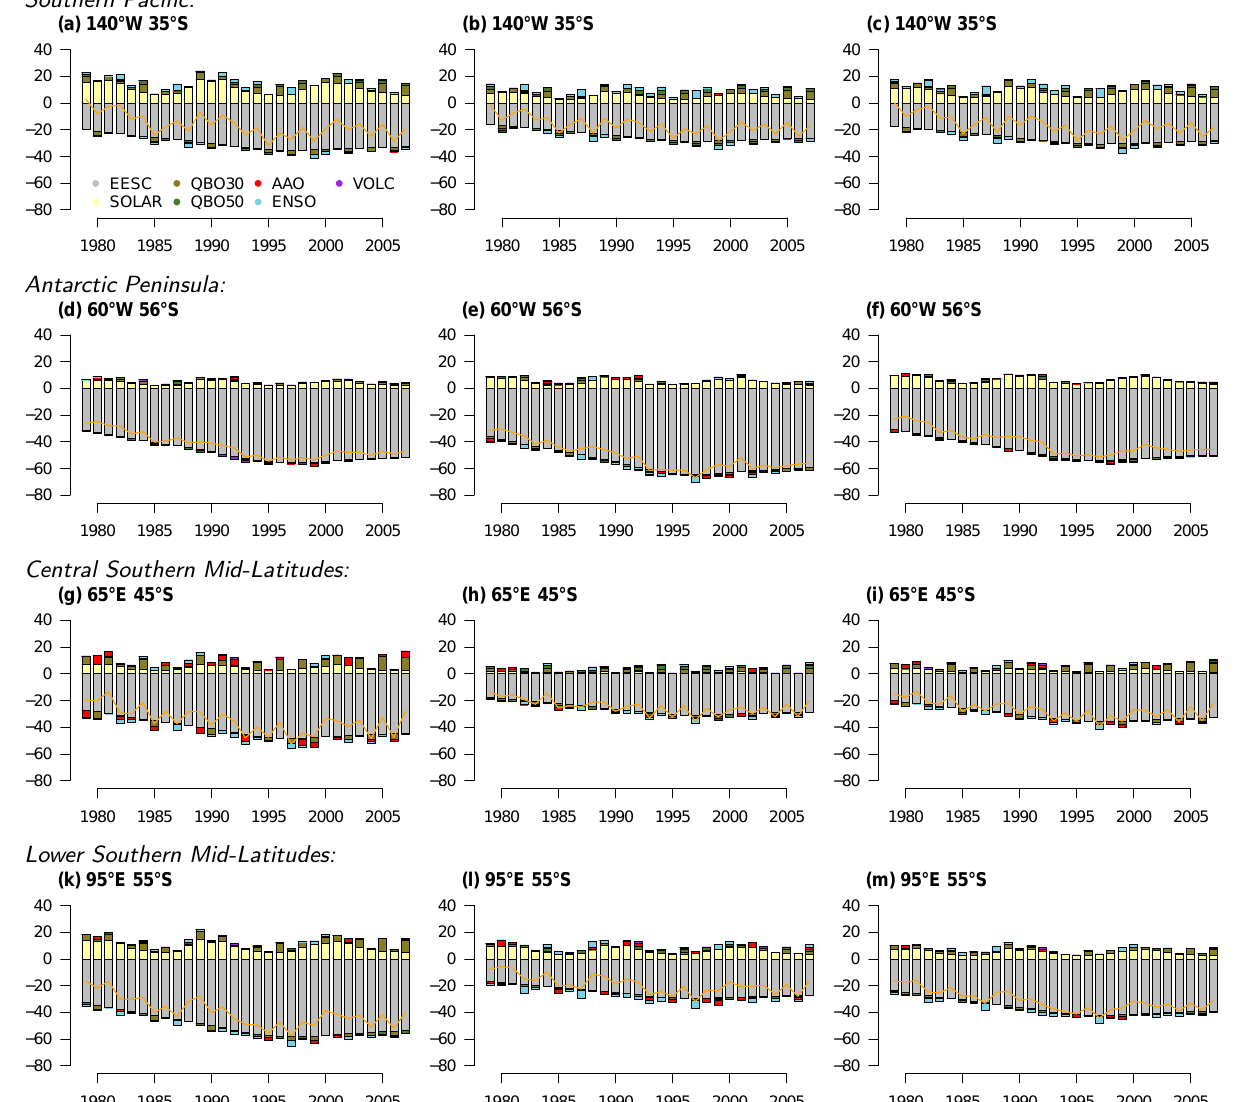
Fig. 10. Contributions of EESC (grey), solar cycle (yellow), QBO at 30 (olive) and 50hPa (green), AAO (red), ENSO (blue), and volcanic eruptions (purple) to long-term ozone changes (on an annual basis in DU) as derived from the r -largest order statistics models for EHOs (left panels (a) , (d) , (g) , (k) ), ELOs (middle panels (b) , (e) , (h) , (l) ), and as derived from the ARMA model for mean values (right panels (c) , (f) , (i) , (m) ) at selected grid cells in the southern mid-latitudes. For convenient reference the solid orange line in panels (a) – (m) gives the net contribution (sum of individual estimates) on an annual